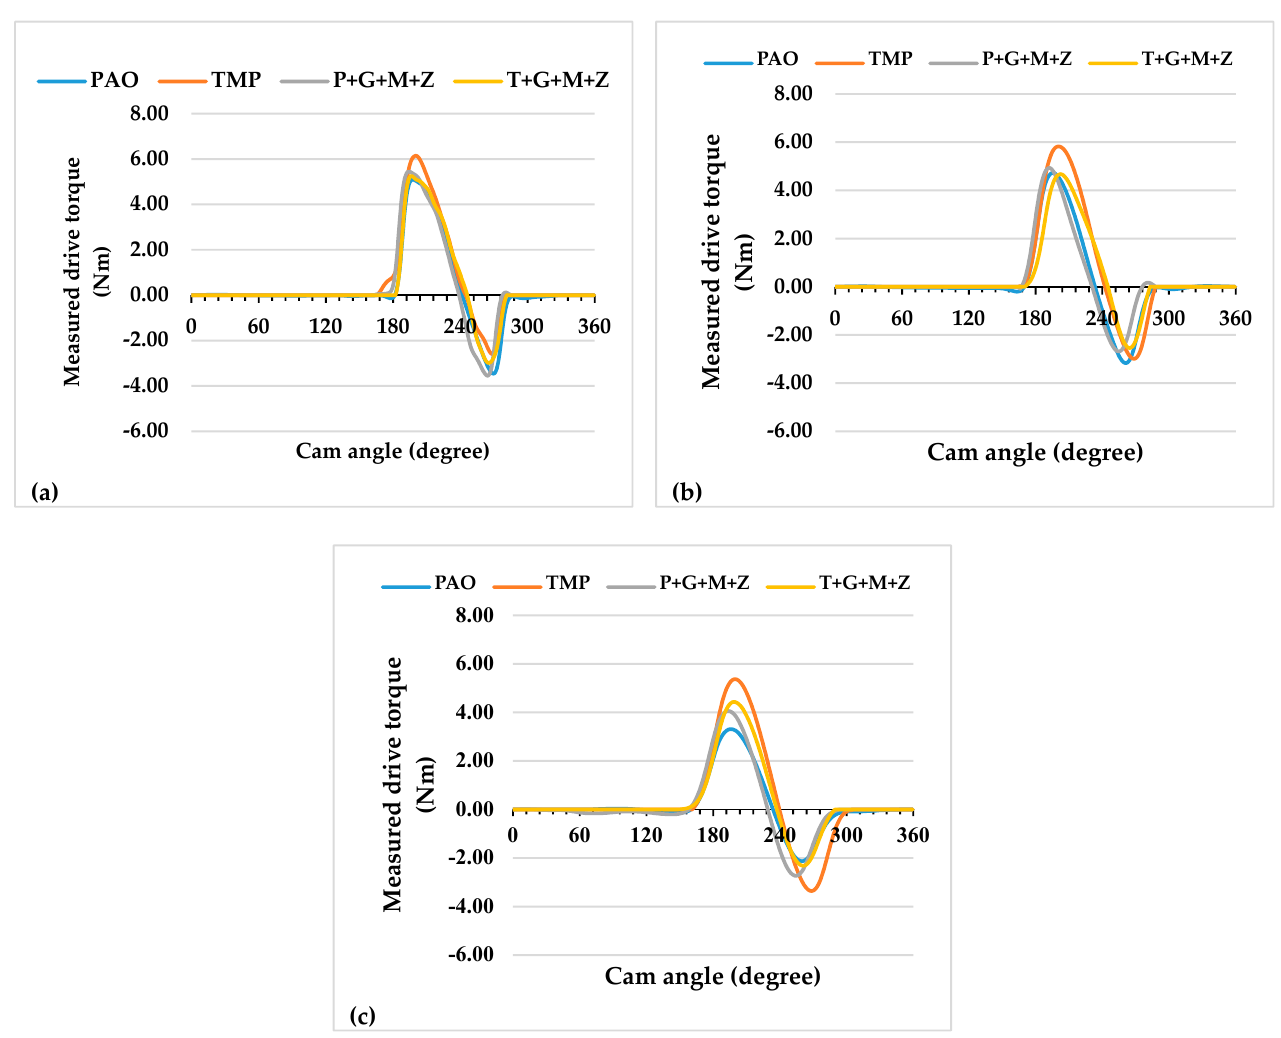
Figure 3. Instantaneous exhaust camshaft drive torque with a-C:H-coated tappets and a-C:H-coated camlobes at a lubricant temperature of 40 °C and camshaft speeds of ( a ) 400 RPM, ( b ) 800 RPM, and ( c ) 1200 RPM.